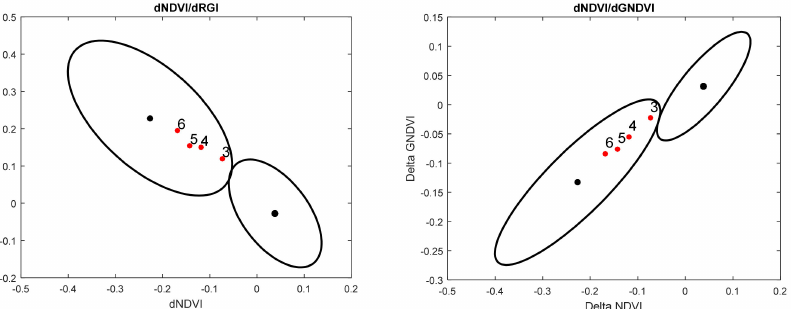
Figure 7. Graphical representation of the location of the centers of the clusters in the feature space for the “dead trees” class adopting different numbers of clusters (3, 4, 5, and 6). The error ellipses for the two classes are shown for comparison with ellipses in Figure